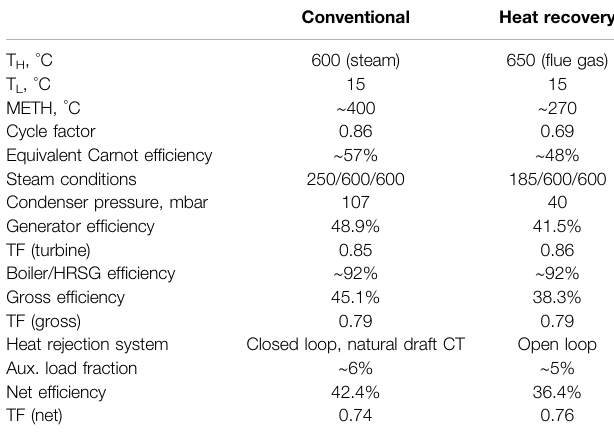
TABLE 3 | Comparison of conventional and heat recovery steam cycle performances.